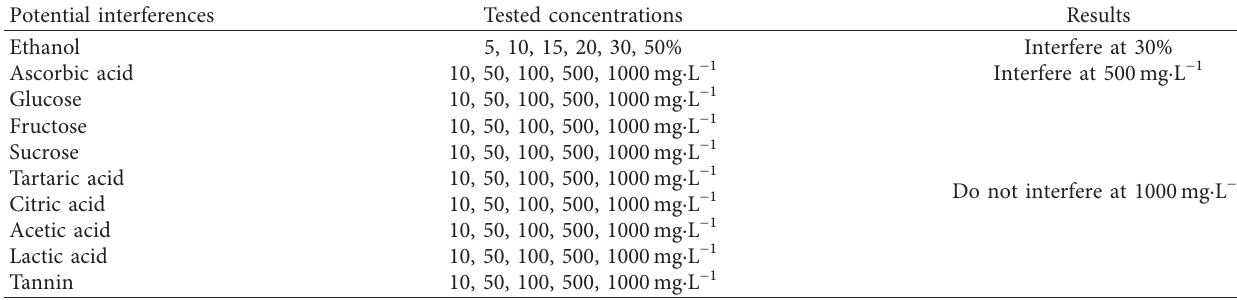
Table 2: Effect of some potential interfering species.